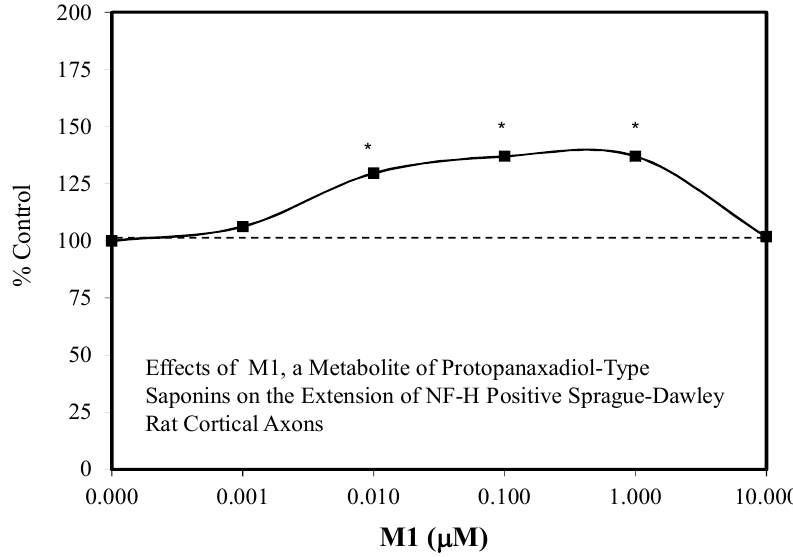
Figure 12. Effects of ginsenoside Rb1 on SH-SY5Y cells against rotenone-induced toxicity (MTT assay) cell viability (source: [43]). Each * represent statistical significance for a data point.